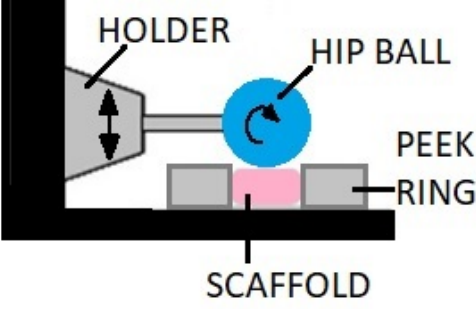
Figure 8. A bioreactor with mechanical loading provided by the ceramic hip